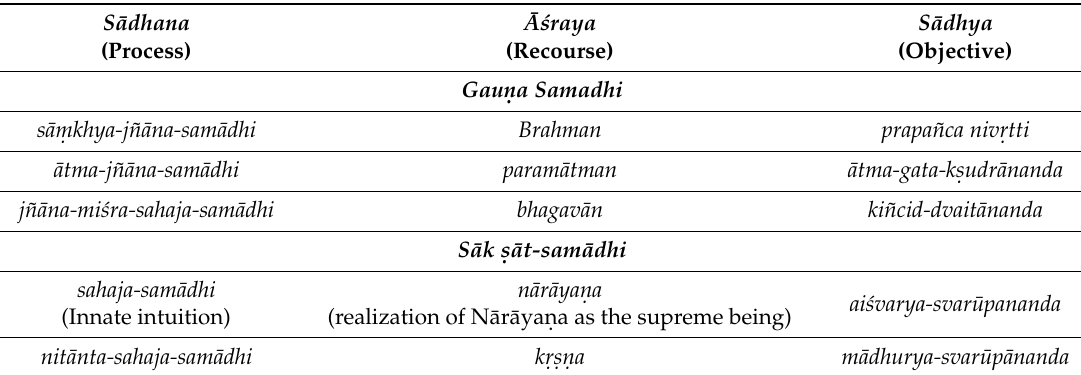
Table 1. States of Sam¯adhi , or Innate Mystic Rapture